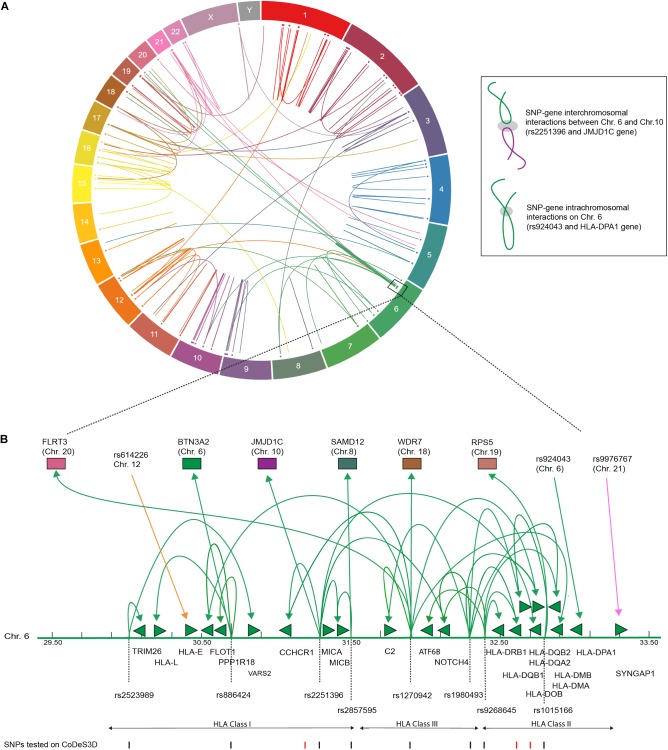
T1D associated SNPs form an integrated gene regulatory network. (A) Circos plot showing eQTL associations between T1D SNPs and eGenes that overlap with Hi-C data. Data tracks: chromosome labels (outer-most ring); and a scatter plot of relative SNP positions. Link lines represent significant SNP-gene interactions at FDR q < 0.05 (Supplementary Table 2). The inset illustrates a cis- and trans-eQTL. The gray ellipsoid represents the unknown factors that are responsible for mediating the physical interaction. (B) T1D associated genetic variants are involved in cis- and trans-eQTLs that enter and emerge from the HLA locus. Significant cis- and trans-eQTLs are annotated by lines with arrows, green arrows heads denoted direction of the regulatory effect. Genes within the HLA locus are annotated as arrows, which indicate transcriptional direction. SNP positions are marked as lines (black – lines indicate significant SNPs, FDR < 0.05). eGenes affected by trans-eQTLs are colored according to chromosome number as in (A).